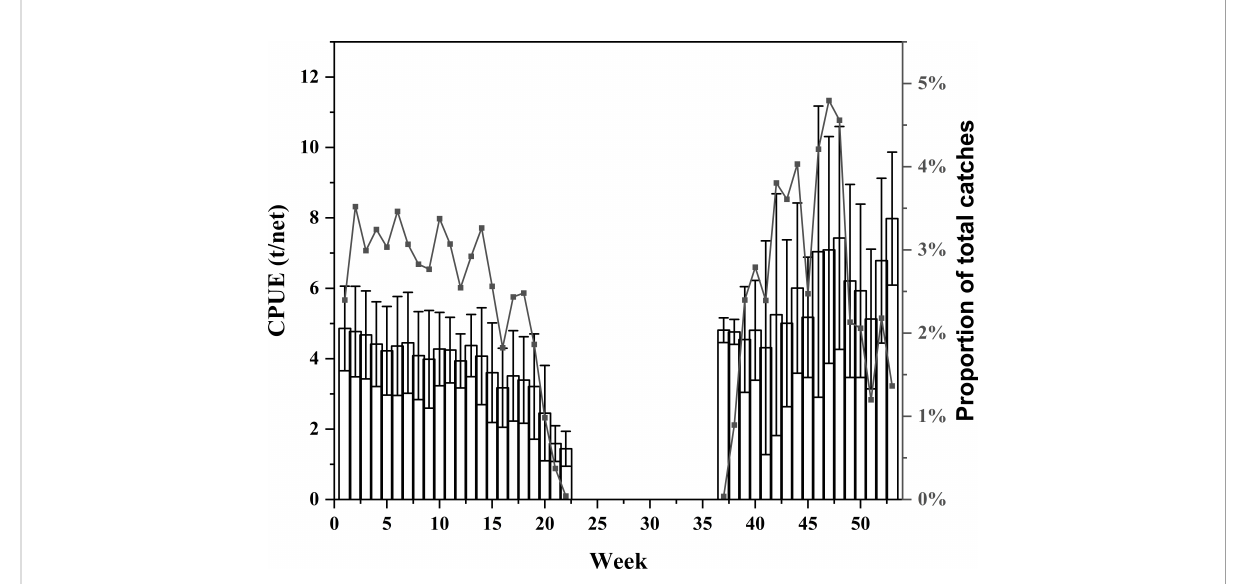
FIGURE 4 Variation in the proportion of total catches (line) and CPUE (bar) of light falling gear in the Northwestern Indian Ocean on a weekly scale (mean ± standard deviation).